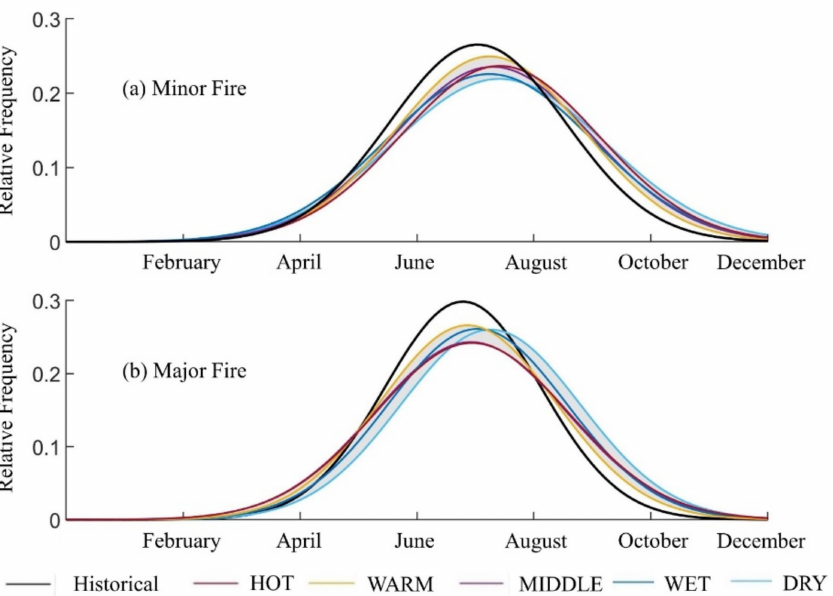
Figure 9. Monthly distribution of ( a ) minor and ( b ) major forest fires under historical (1986–2015) and future (2070–2099) climate